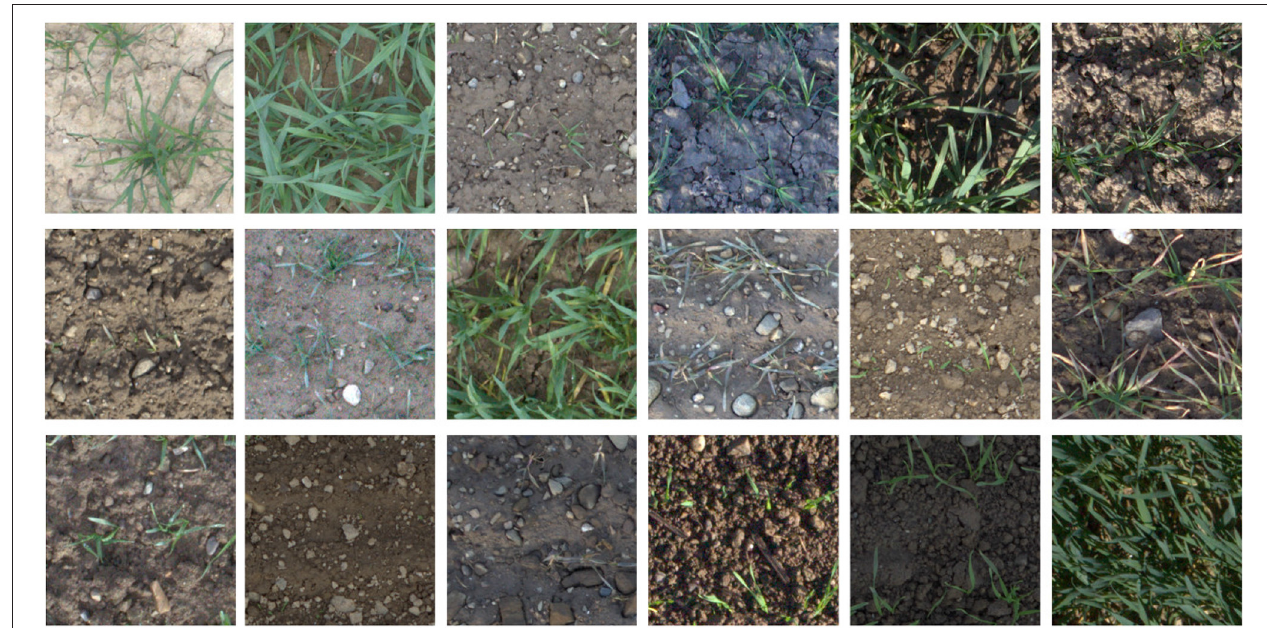
FIGURE 1 | Overview of variance in images from the Eschikon wheat segmentation (EWS) dataset of images taken between 2017 and 2020 with a Canon 5D Mark II full-frame RGB camera integrated into the sensor head of the field phenotyping platform of ETH Zurich ( Kirchgessner et al.,